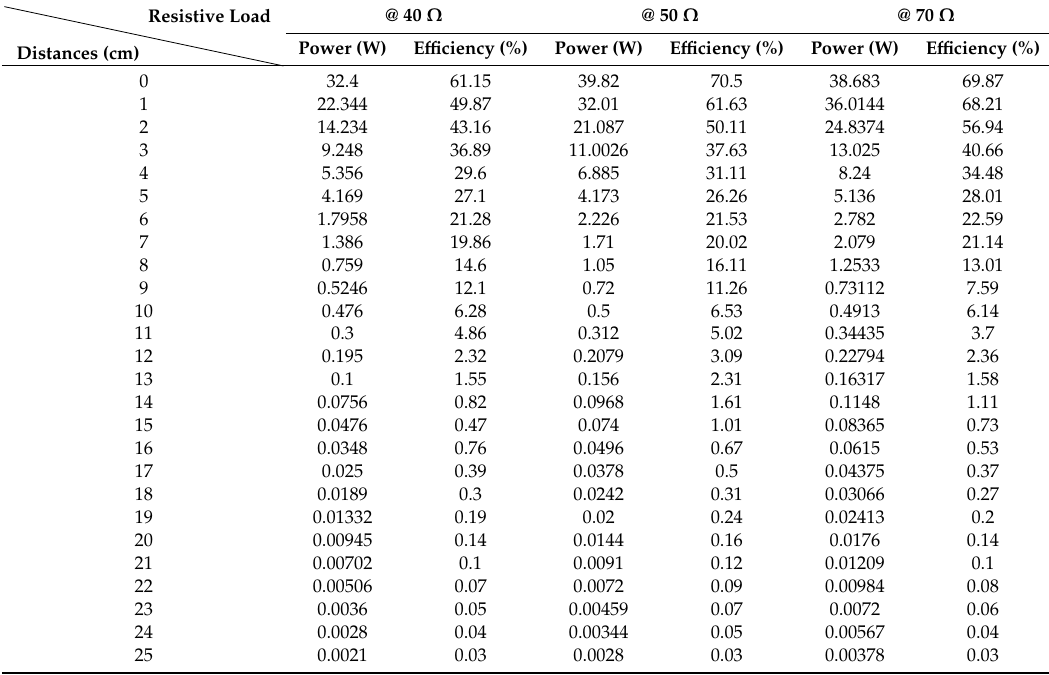
Table 3. The parameters for MRC based-loads at first topology.